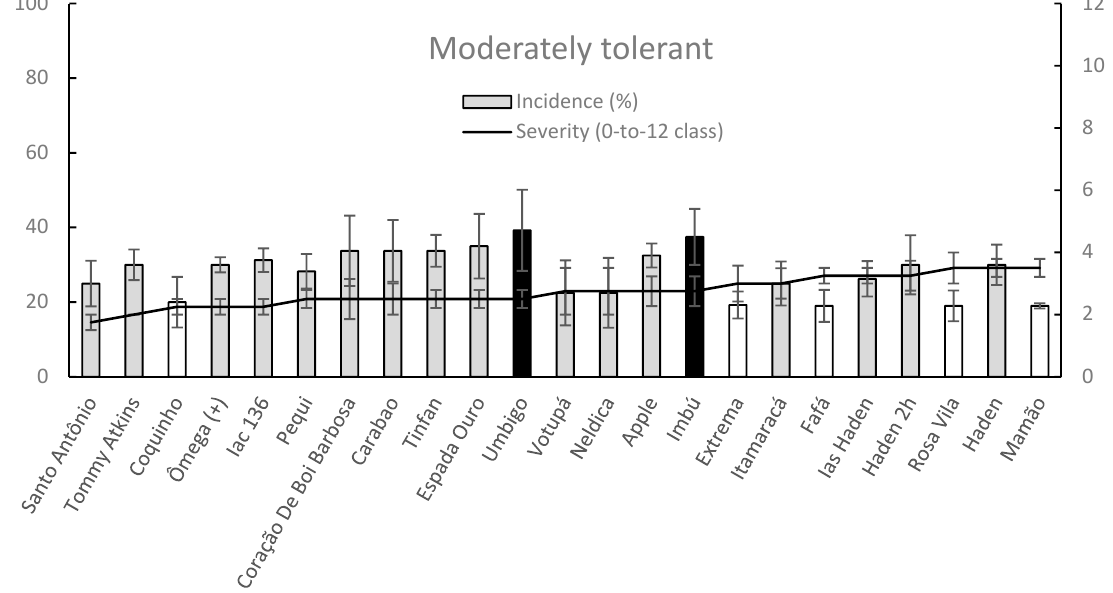
Figure 7. Column-line graphs on two axes comparing anthracnose incidence and severity caused by C. asianum within moderately tolerant mango cultivars. Data ( ± SE values) were collected and analyzed as above done for previous figures. Grey colors of columns, as well as the absence of letters above the points of line, clearly show the lack of significant differences according to both parametric and nonparametric approaches.